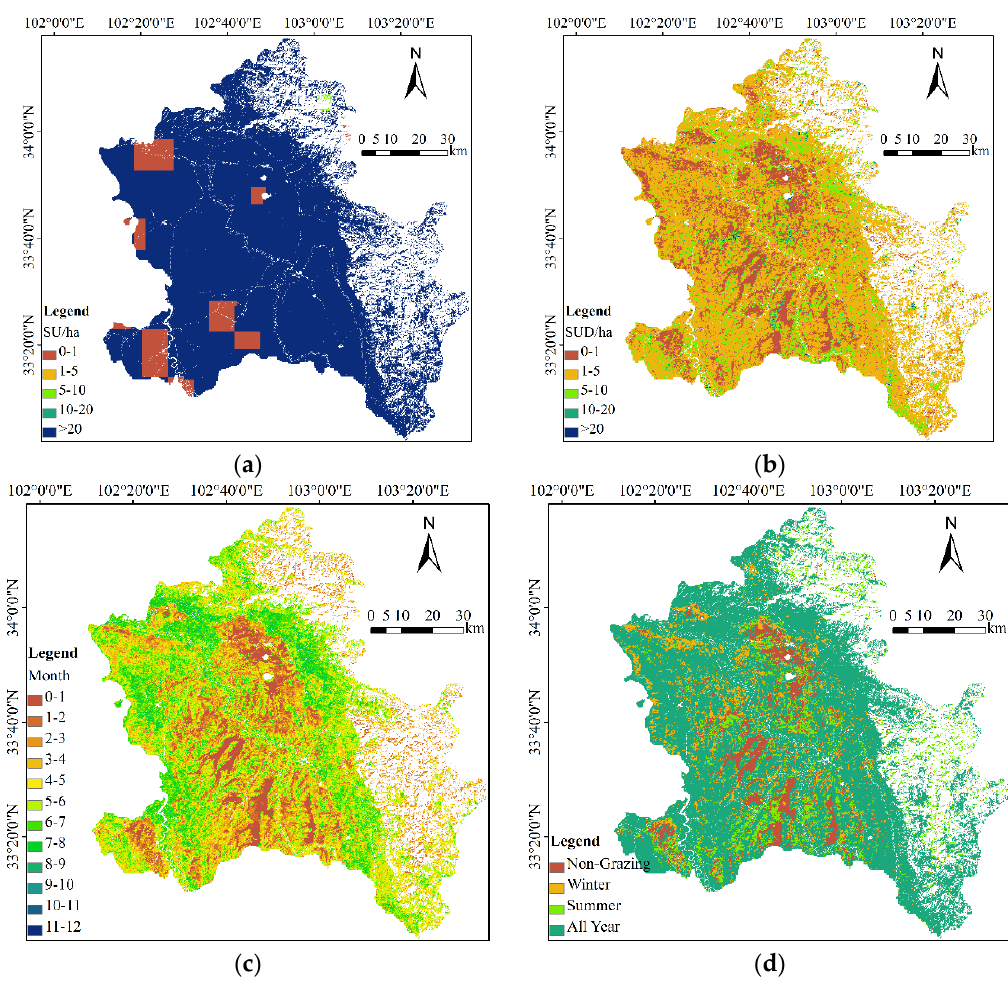
Figure 6. Spatial distribution of the grazing intensity obtained respectively from ( a ) “Gridded Livestock of the World” (unit: sheep unit per ha, SU/ha); ( b ) time-series remote sensing data (annual average grazing intensity, unit: SUD/ha); ( c ) the grazing period of the pastures in 2012 (unit: month); and ( d ) the pasture types in Zoige County.